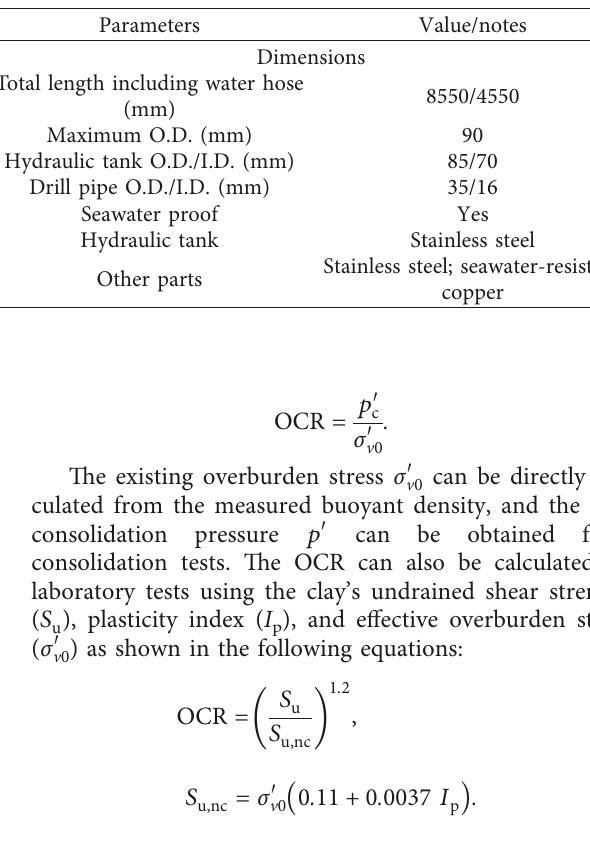
Table 1: Technical parameters of the Wison-APB 50/100 kN (AP van den Berg,